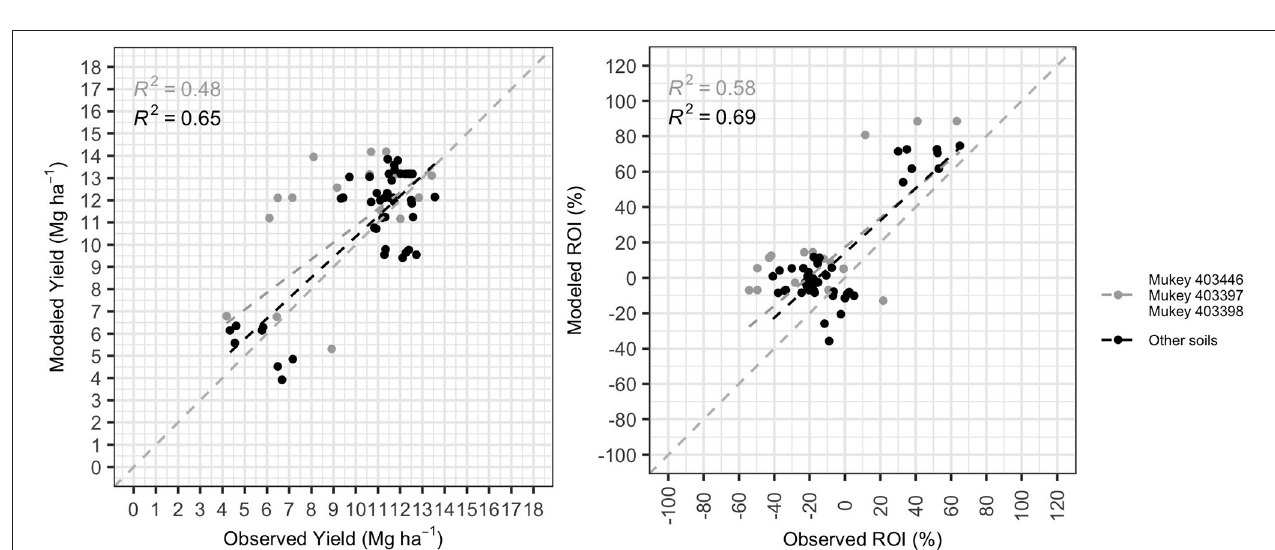
FIGURE 3 | Modeled yield and ROI values fit to observations obtained from spatially averaged precision yield monitor data. Gray data points represent data removed from soils with small areal extent located near the field boundary.